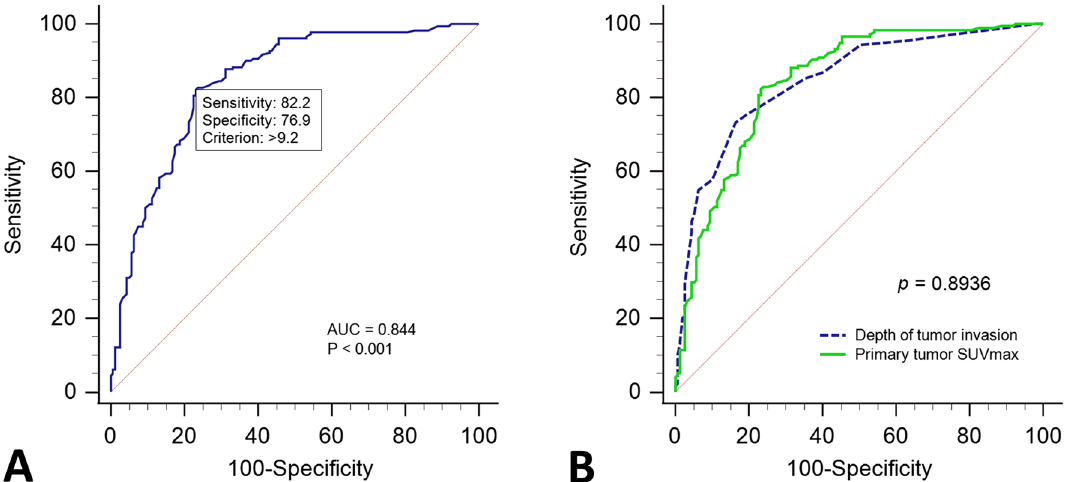
Figure 2. ( A ) Receiver operating characteristic (ROC) curve of primary tumor SUVmax (tSUVmax) value for predicting bone invasion of patients with pathologic positive results. The optimal cutoff point based on the Youden index is 9.2; the area under the curve (AUC) is 84.5% (95% confidence interval 0.801–0.881) (p < 0.0001). ( B ) Pairwise comparison of ROC curves of depth of tumor invasion (DOI) and tSUVmax for predicting bone invasion. The optimal DOI cutoff point for predicting bone invasion is 9 mm. AUC for DOI is 84.8% (95% confidence interval 0.805–0.885) and that for tSUVmax is 84.5% (95% confidence interval 0.801– 0.881) (p =